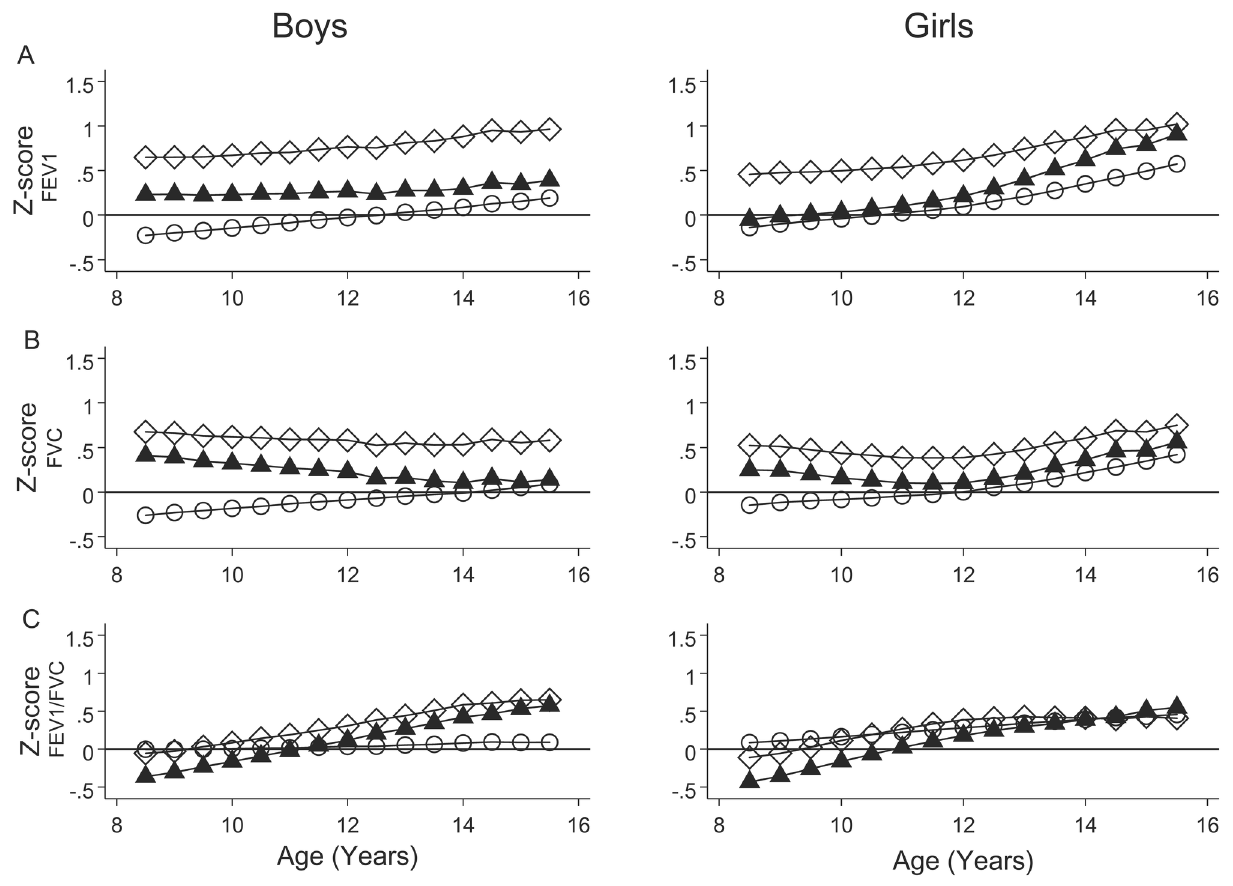
Figure 1. Lung function growth of a cohort of Mexican children compared with international spirometric reference equations. Forced expiratory volume in 1 s (FEV ) (panel A), Forced vital capacity (FVC) (panel B), the ratio of FEV 1 (FEV /FVC) (panel C) vs. age in years of children from Mexico City is expressed as Z-score of the international study of lung 1 function by Quanjer et al. (empty diamond), Mexican-American children from the National Health and Nutrition Examination Survey III (NHANES III) study (full triangles), and Mexican children from a cross-sectional study (empty circles). The majority of values for age-, gender-, and height-adjusted FEV and FVC in Mexican children from the reported cohort are positive compared with those of 1 children from international studies and of Mexican-American children, indicating higher spirometric lung function, and these in addition change position during growth relative to predicted values. The better the fit, the closer the median Z-score will be to zero at all